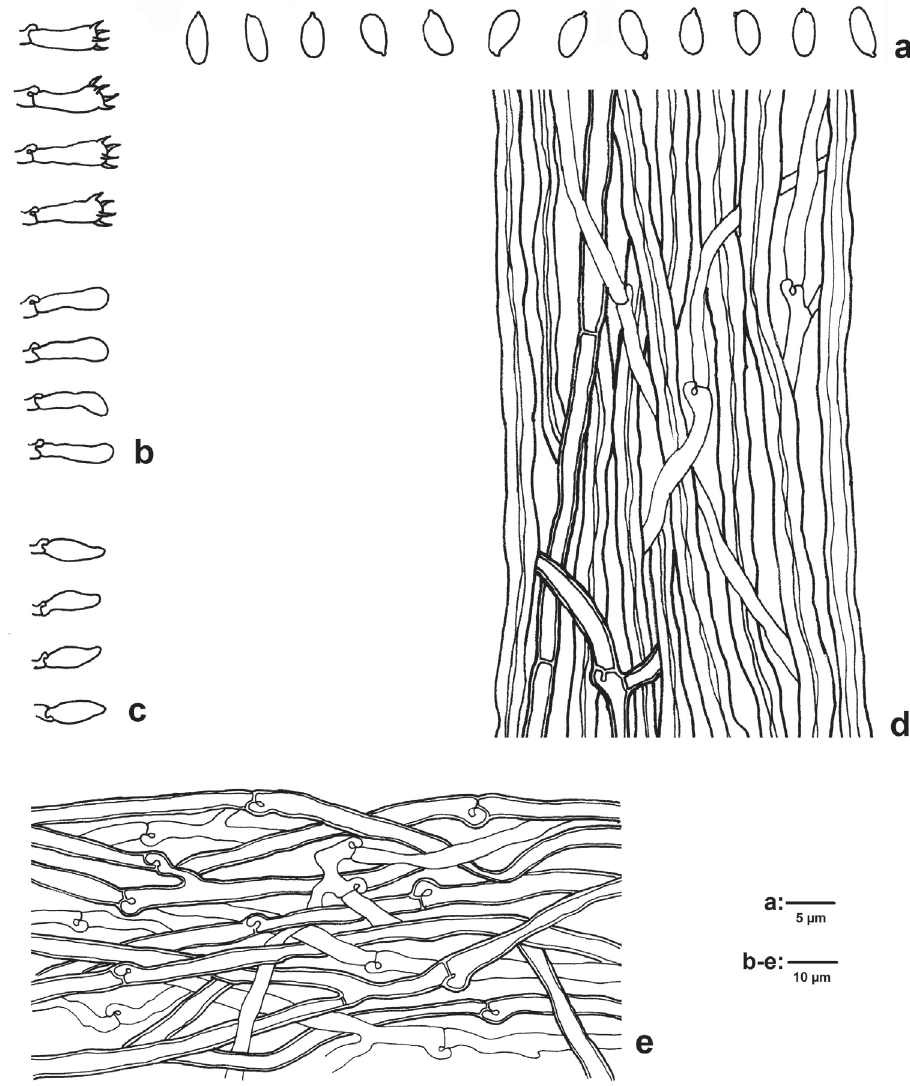
Figure 3. Microscopic structures of Mycorrhaphium subadustum (IFP 019374, holotype) a Basidiospores b Basidia and basidioles c cystidioles d Hyphae from spine trama e Hyphae from context.